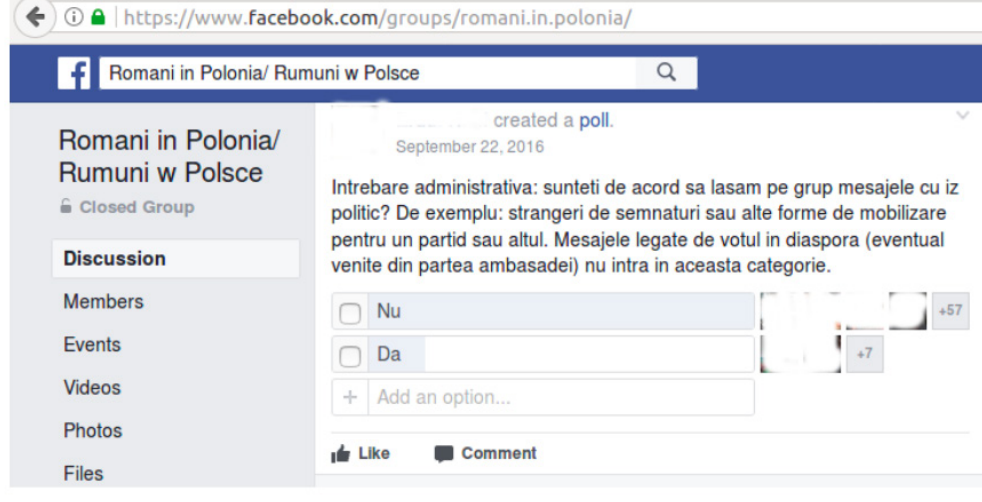
Figure 1. Screenshot of the political talk ban proposal discussion on the Romani in Polonia